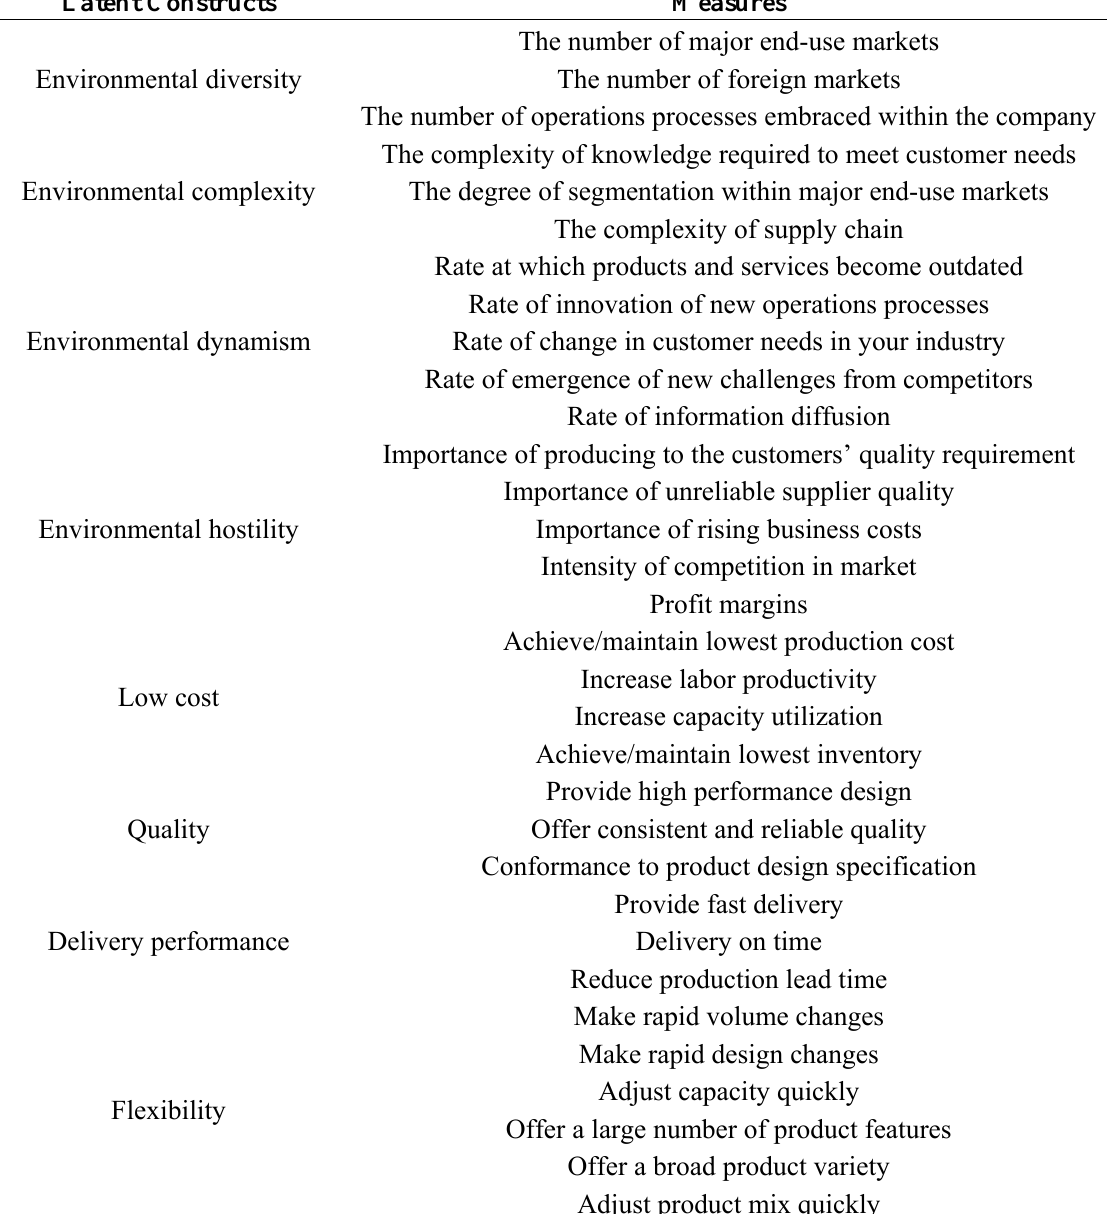
Table A1. Latent Constructs and Corresponding